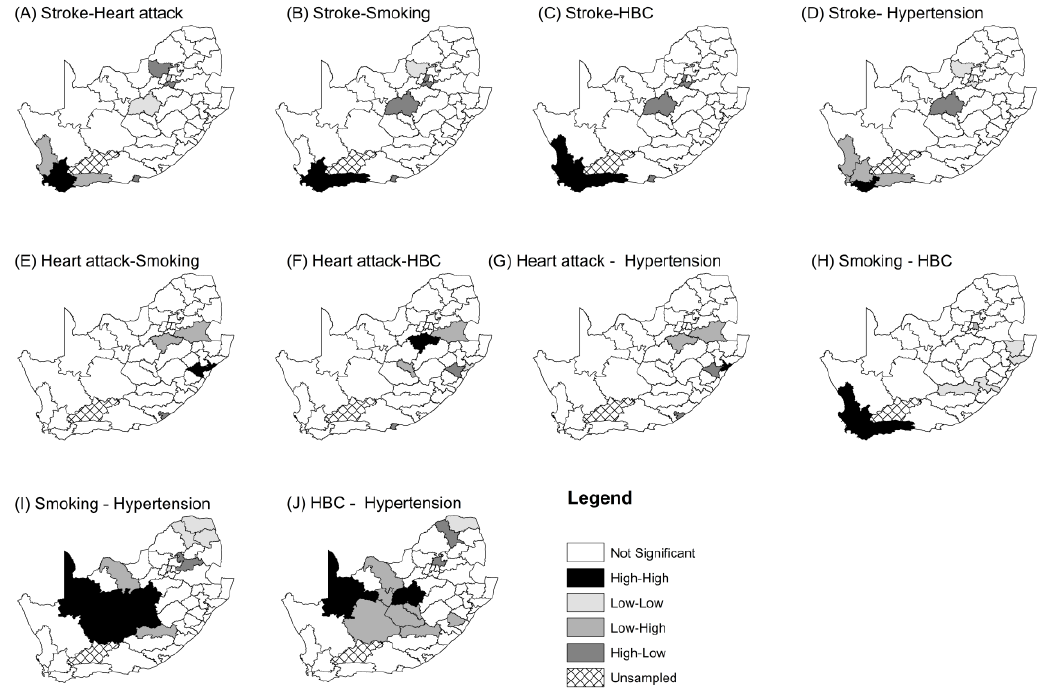
Figure 4. Joint spatial clusters of CVDs and their risk factors with significant association for all participants, adjusted for the national age-sex distribution of the sample.